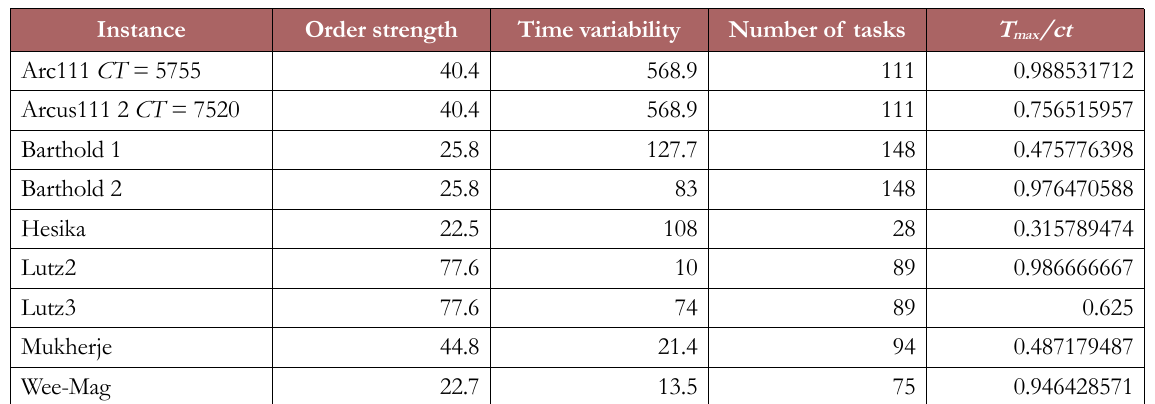
Table 4. Used instances